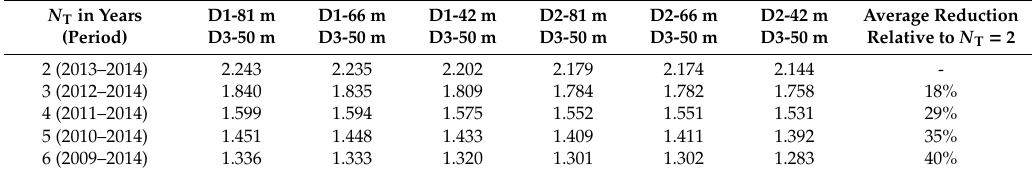
Table 5. Historical uncertainty ( σ H ) considering different wind monitoring campaign lengths [%]. N T in Years